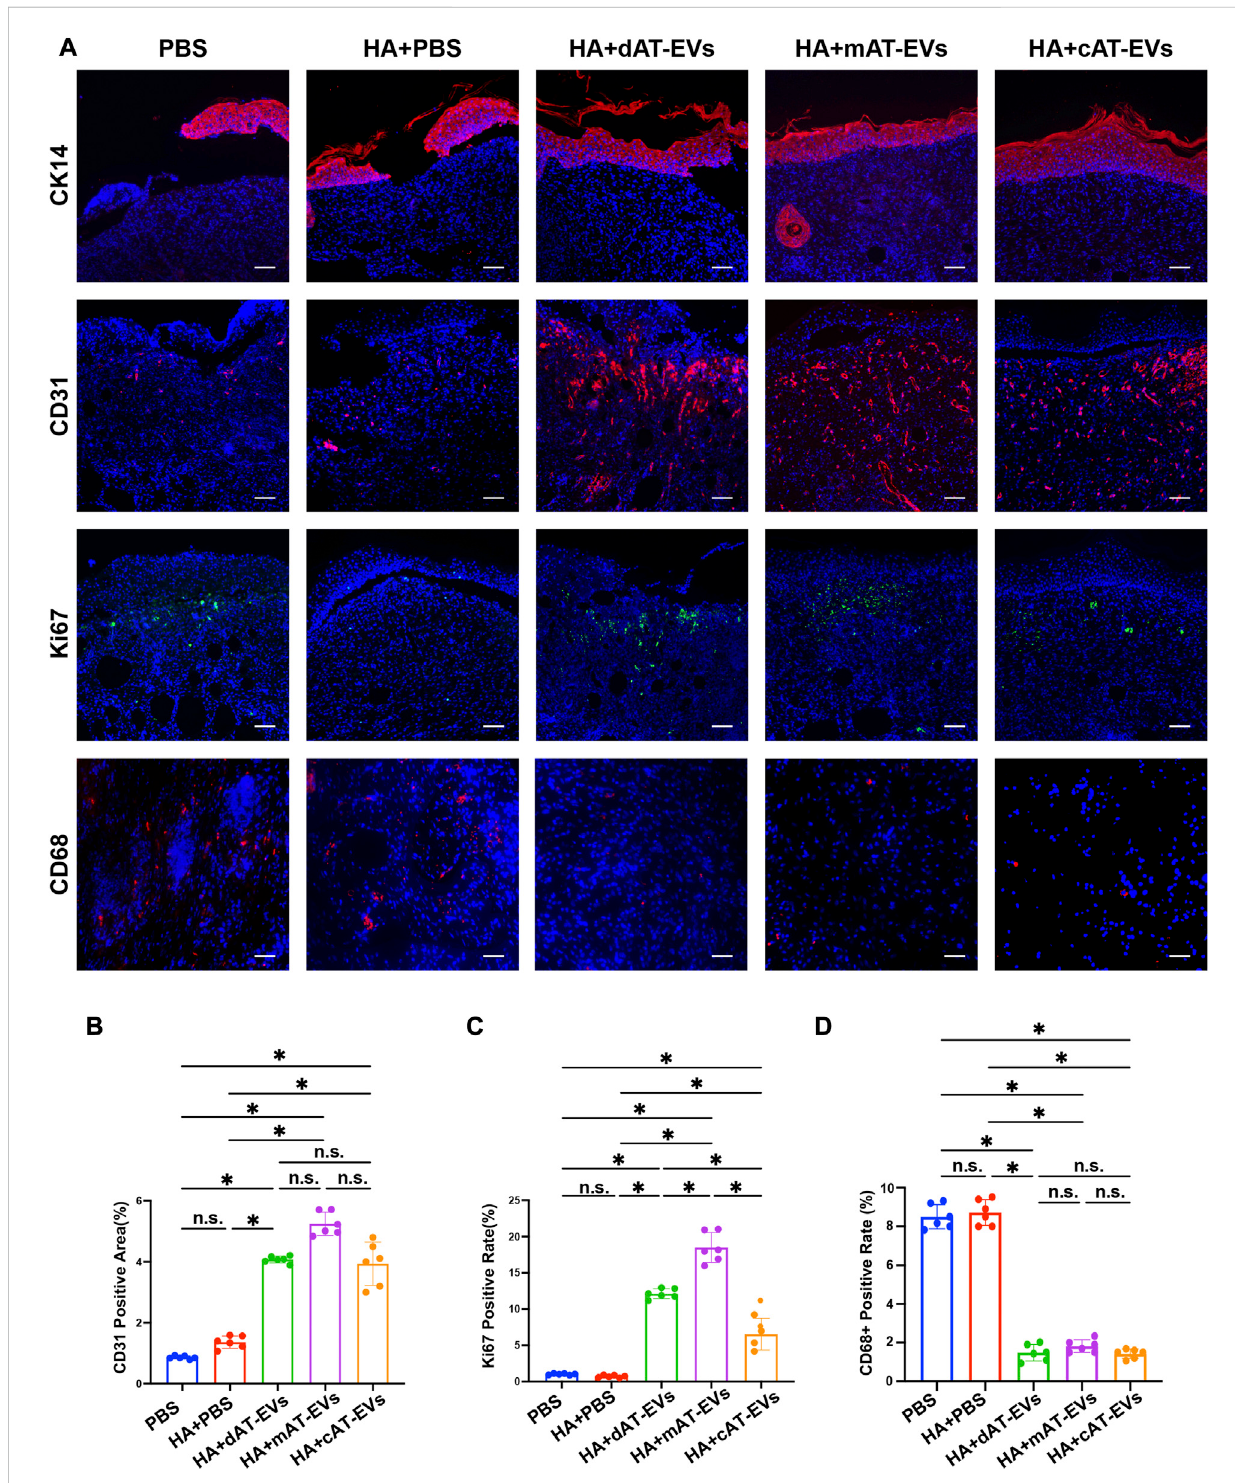
FIGURE 8 AT-EVs promoted cell proliferation, keratinocyte differentiation and migration, and angiogenesis while decreasing in fl ammation in vivo (A) Immuno fl uorescent staining of CK14 (red), CD31 (red), and Ki67 (green), representing keratinocyte differentiation and migration, angiogenesis, and cell proliferation, respectively, as well as CD68 (red), representing in fl ammatory cells, observed under a fl uorescence microscope. Scale bar = 75 μ m. (B) Statistical analysis of CD31-positive area ( n = 6). (C) Statistical analysis of Ki67-positive cells ( n = 6). (D) Statistical analysis of CD68-positive cells ( n =